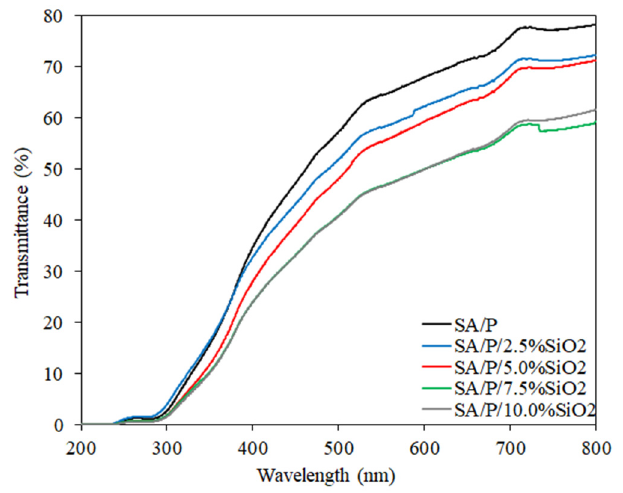
Figure 6. Light transmission profile (%) of SA/P and SA/P/SiO 2 films.